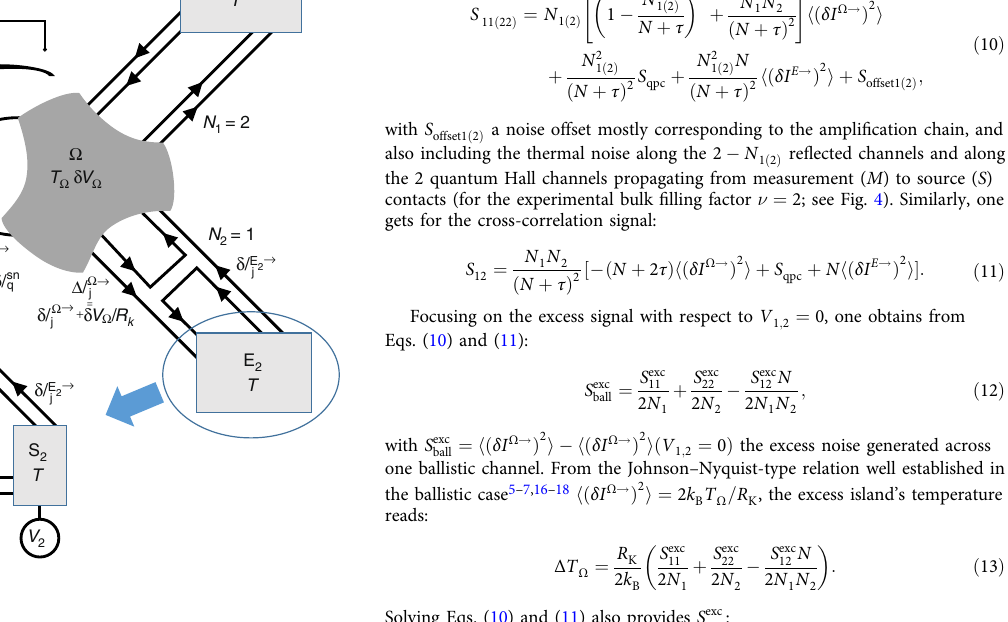
Fig. 4 Noise schematic. Graphical representation of the different current and voltage fl uctuations discussed in the